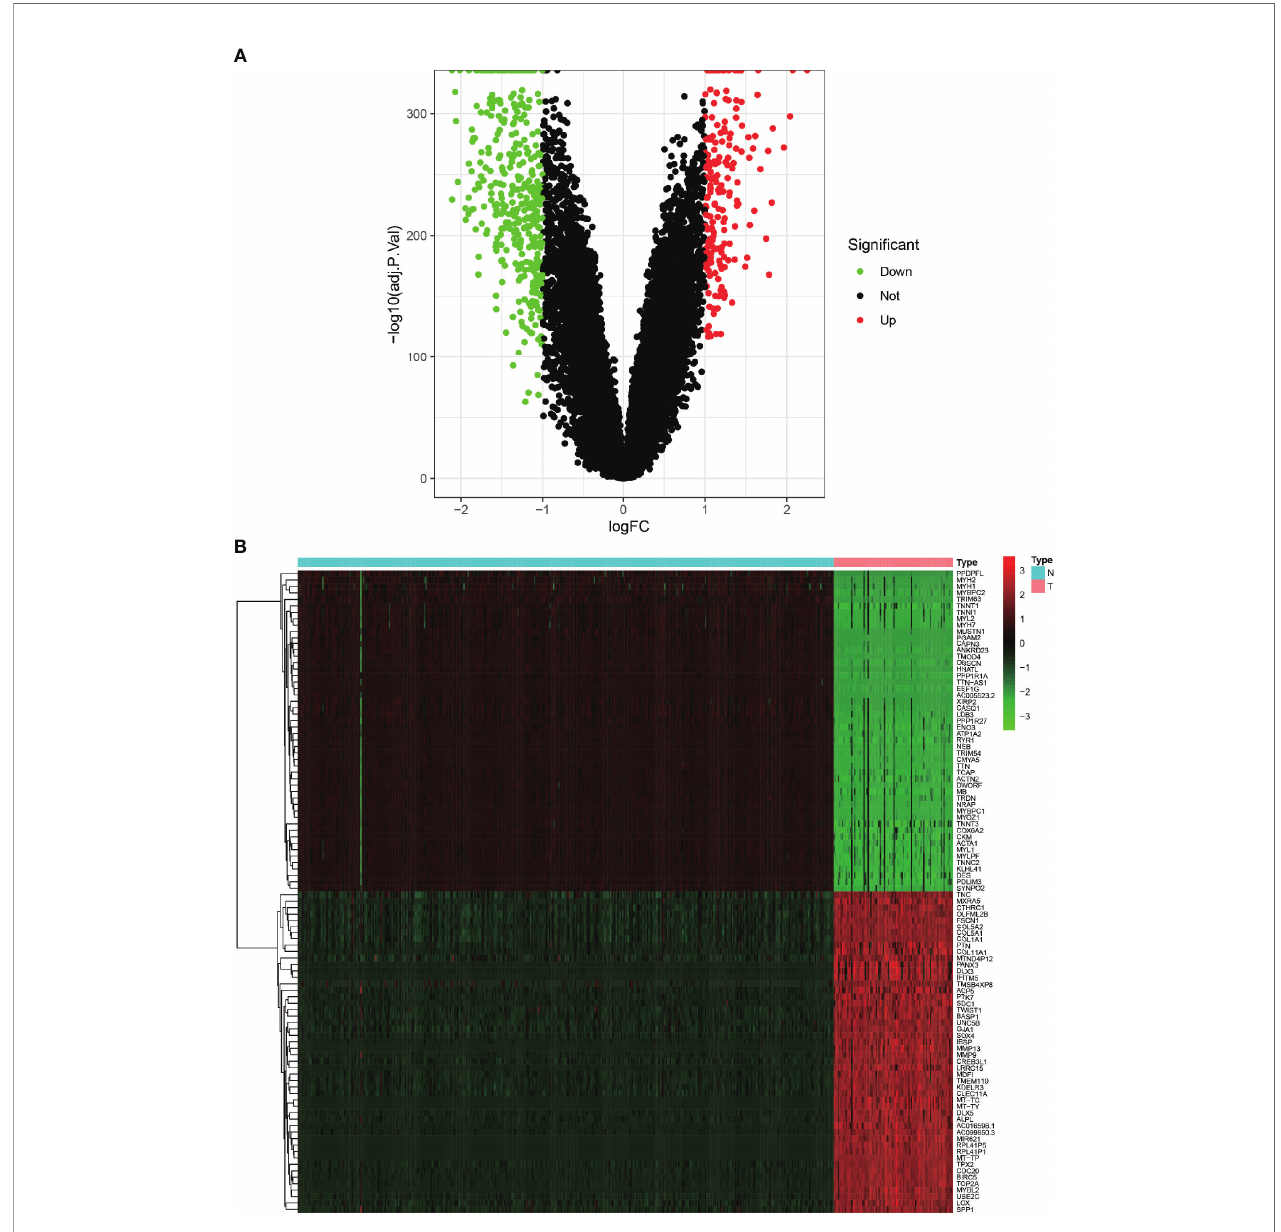
FIGURE 2 | Heat map and volcano map of differentially expressed genes. (A) green dots indicate down-regulated differential genes, red dots indicate up-regulated differential genes, and black dots indicate other genes that do not meet the screening criteria. (B) Heat map of differentially expressed genes, red squares indicate highly expressed